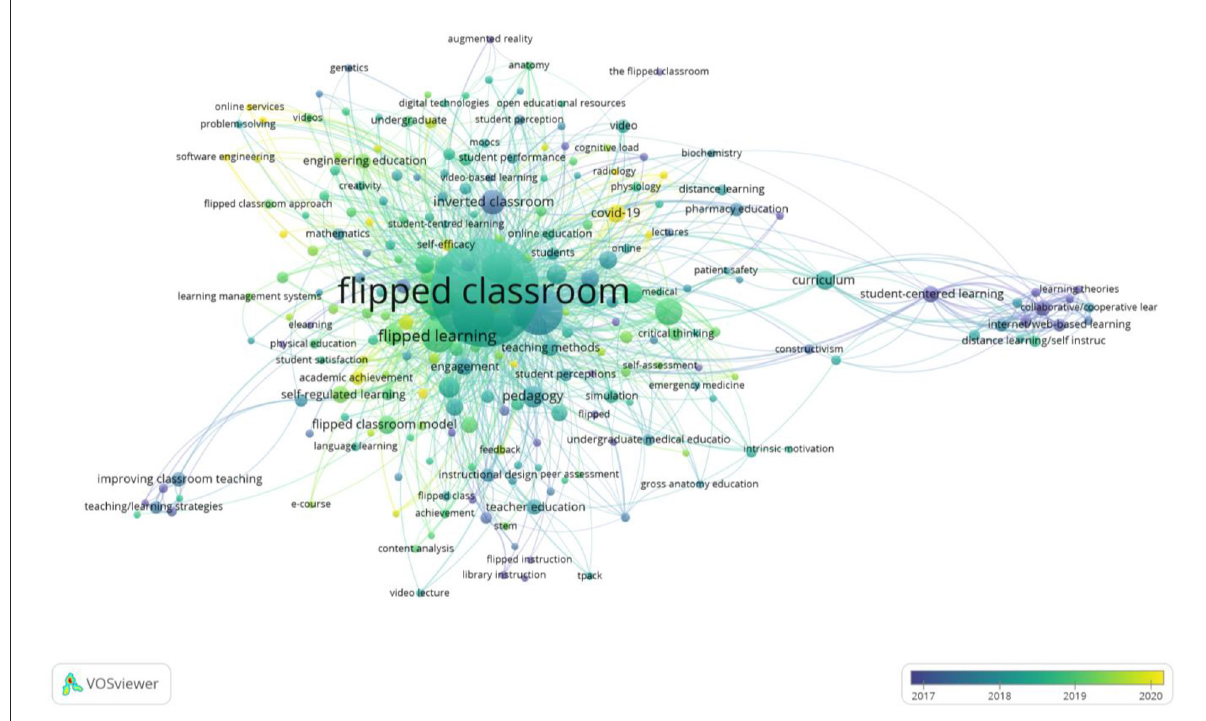
FIGURE9 Map according to time. Source: Created by authors with